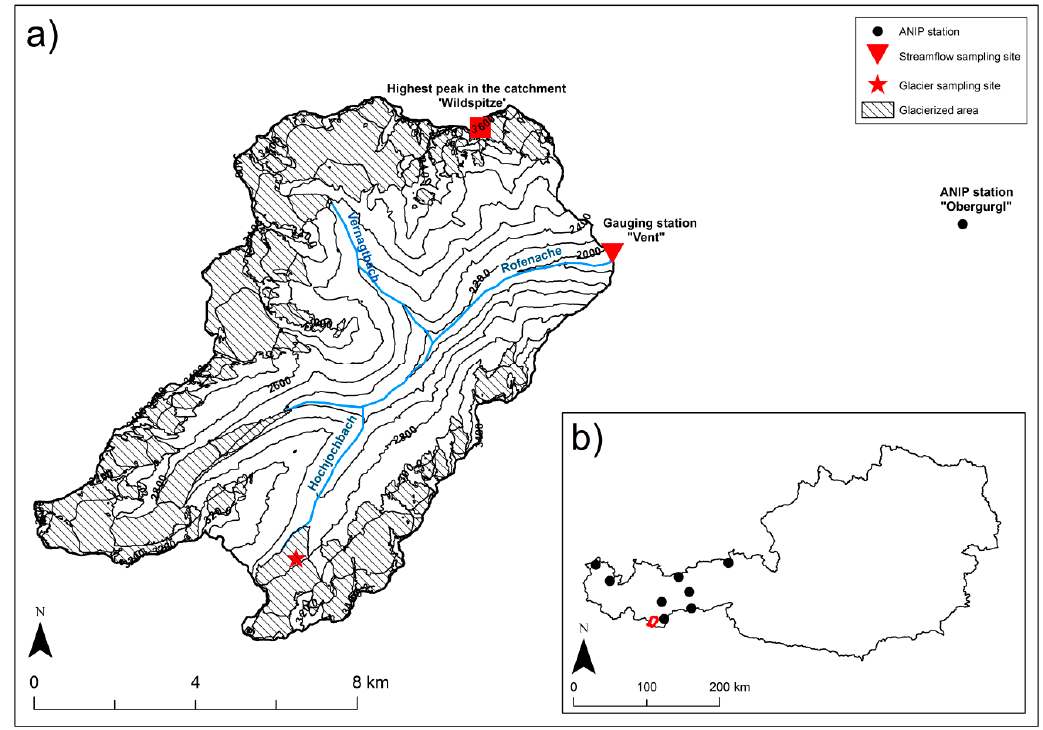
Figure 1. ( a ) Rofental with sampling sites and ( b ) location of Rofental (red) in Austria and the Austrian Network of Isotopes in Precipitation and Surface Waters (ANIP) sites (crosses) used for the derivation of isotopic lapse rates.